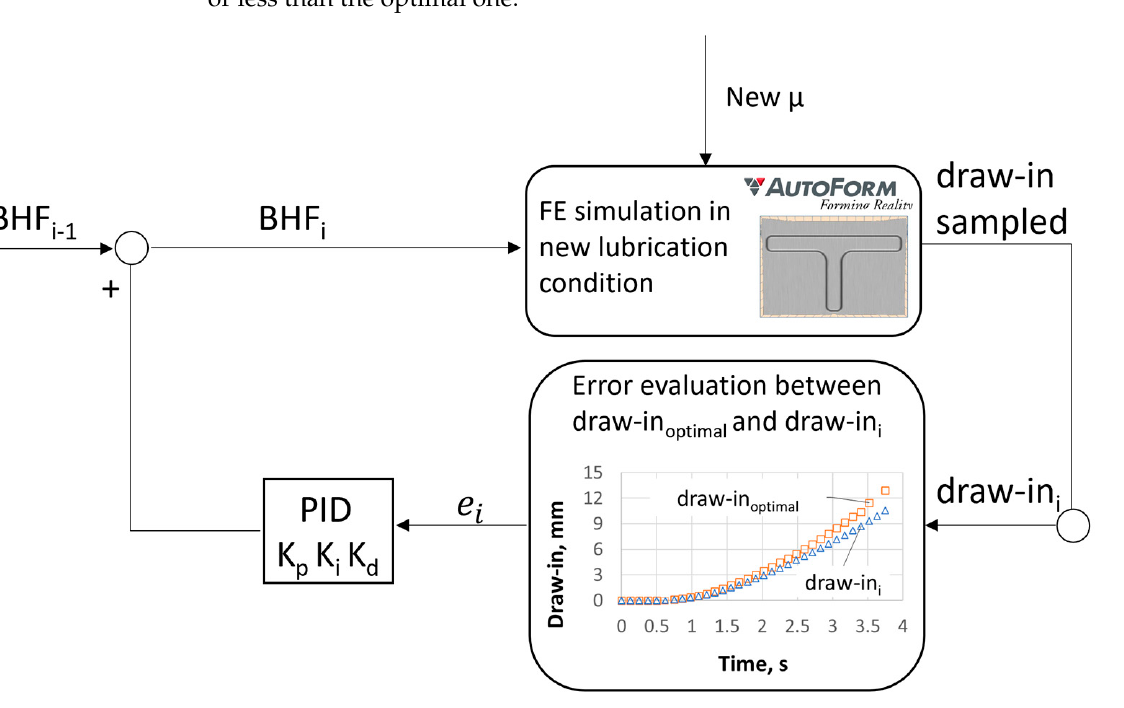
Figure 6. Block diagram of the feedback control.